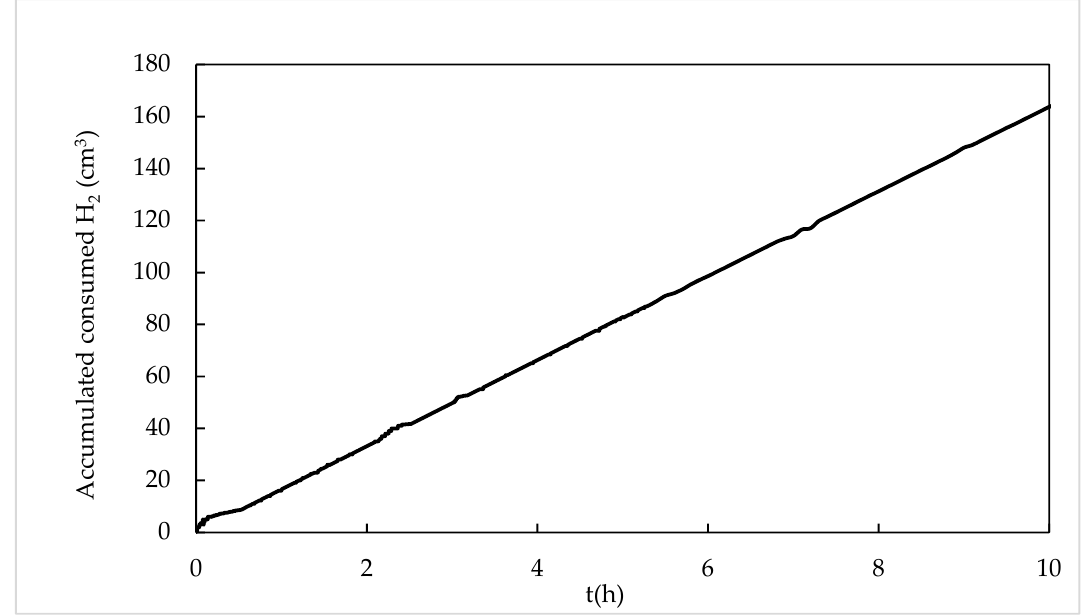
Figure 3. H 2 consumption versus time in the hydrogenation of toluene with catalyst SA20-RhCOD (333 K, 10 bar H 2 ).